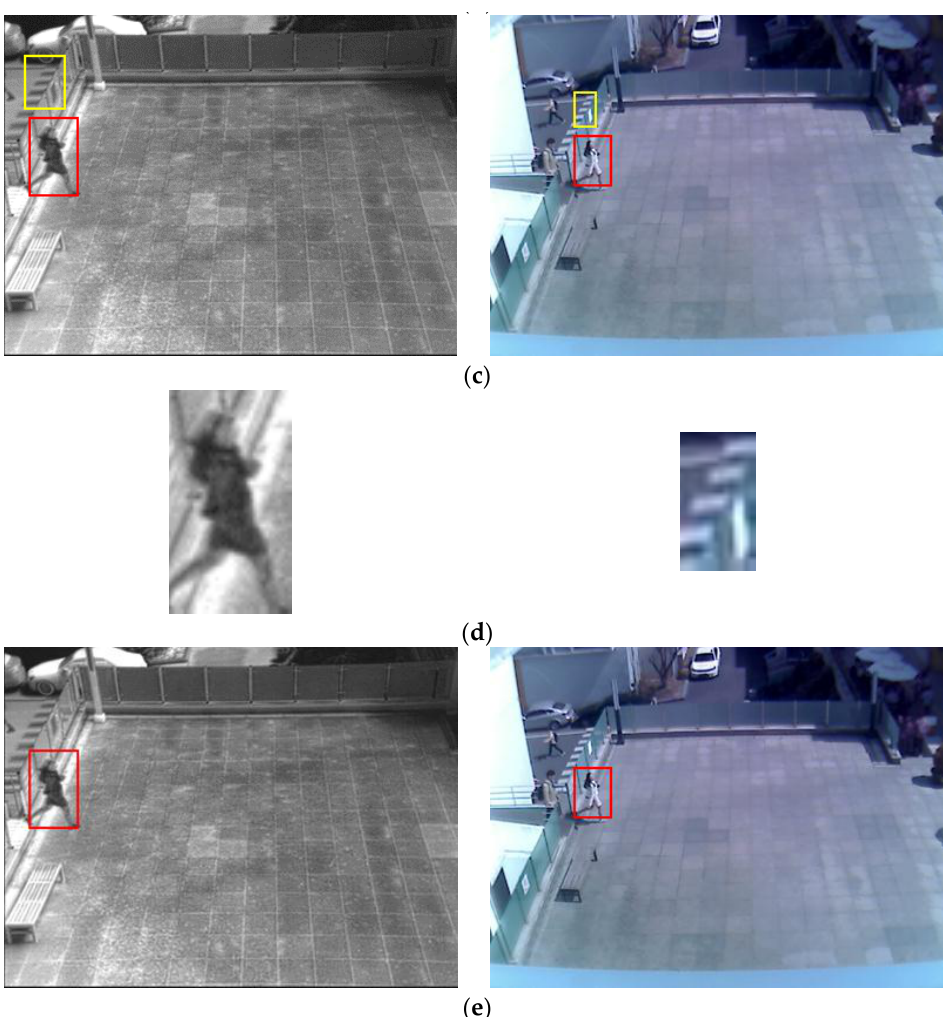
Figure 2. Images to illustrate the steps shown in Figure 1: ( a ) Two input images, ( b ) Two difference images, ( c ) Detected candidate boxes by background subtraction and noise reduction. ( d ) Selected candidate boxes by FIS, which are used as CNN inputs. ( e ) Final detected area of containing the pedestrian by CNN.